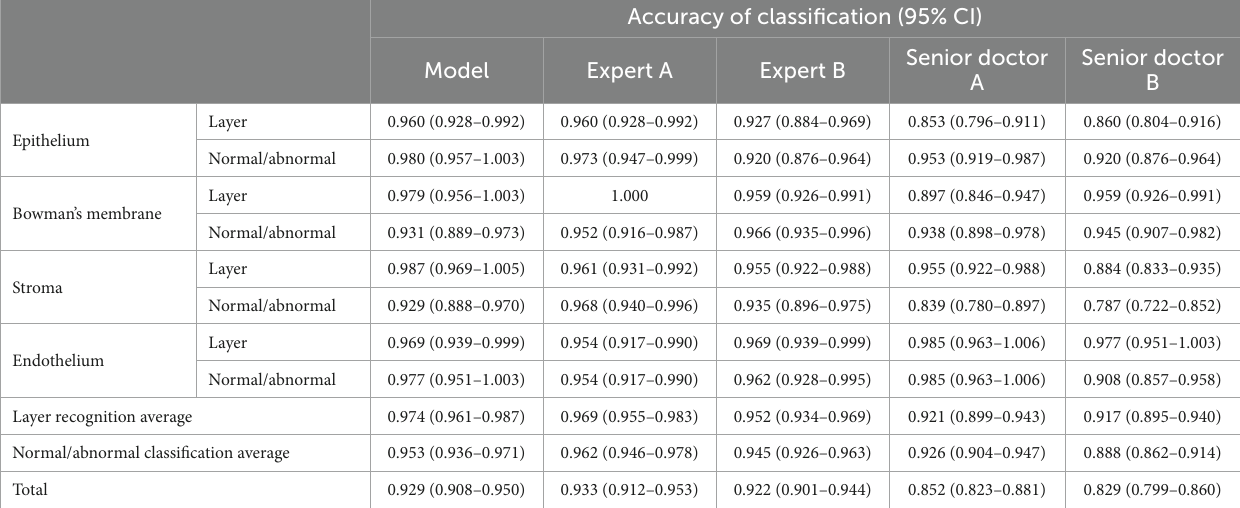
TABLE 2 Comparison of the performance of the model and